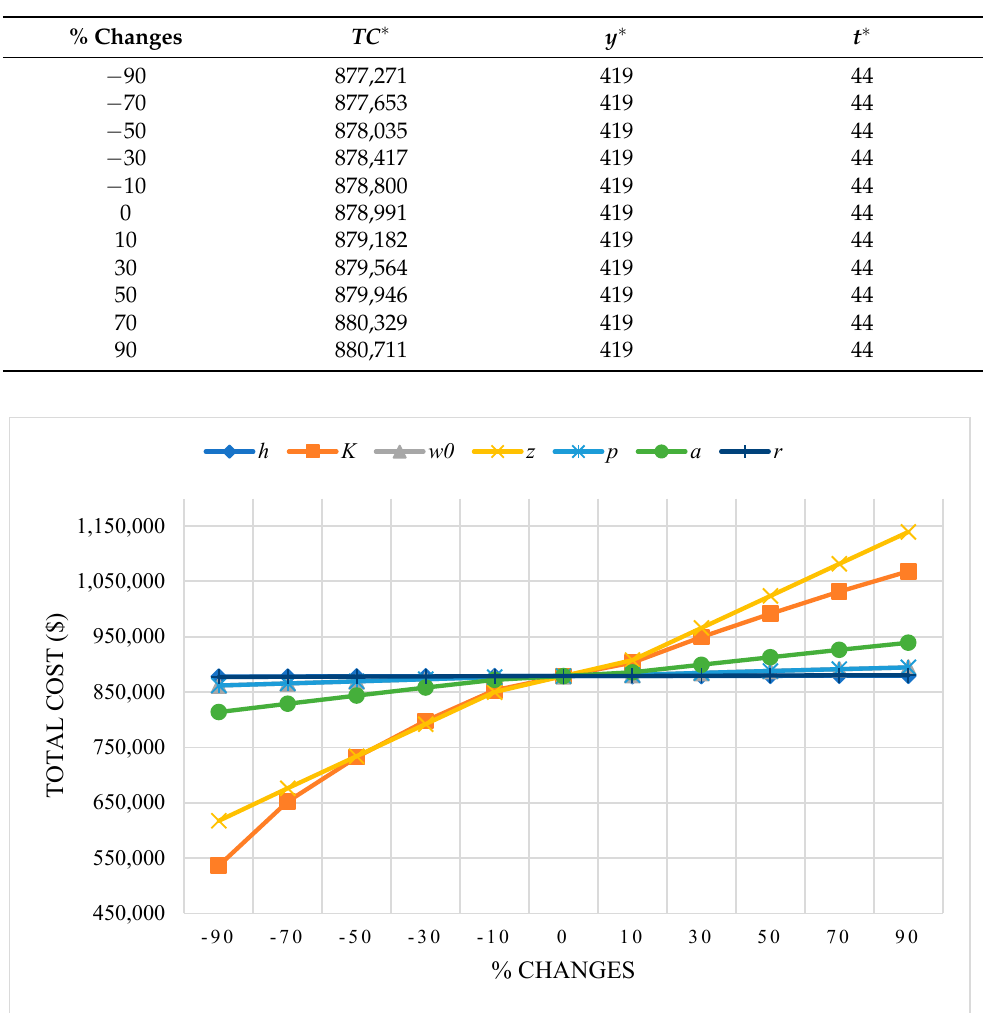
Table 8. Sensitivity analysis of the disposal cost ( r ).